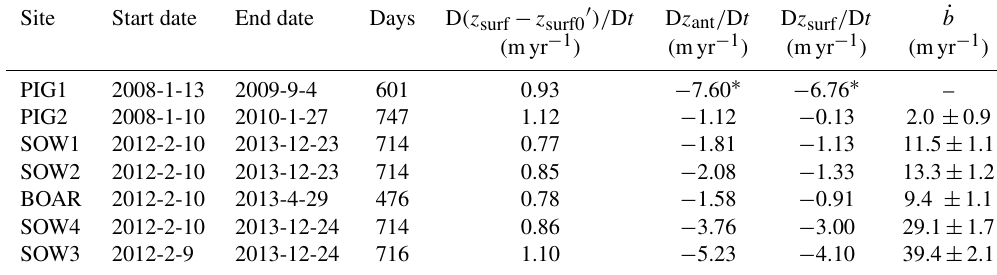
Table 1. GPS station data. Fields include surface elevation change relative to tracer for initial surface D (z surf − z surf0 (cid:48) )/ D t , antenna elevation change D z ant / D t (equal to pole-base elevation change), surface elevation change D z surf / D t , and corresponding ice-equivalent basal melt rate ˙ b . ∗ PIG1 values over grounded ice do not include correction to remove expected D z surf / D t due to advection along local surface slopes ( V 0 )